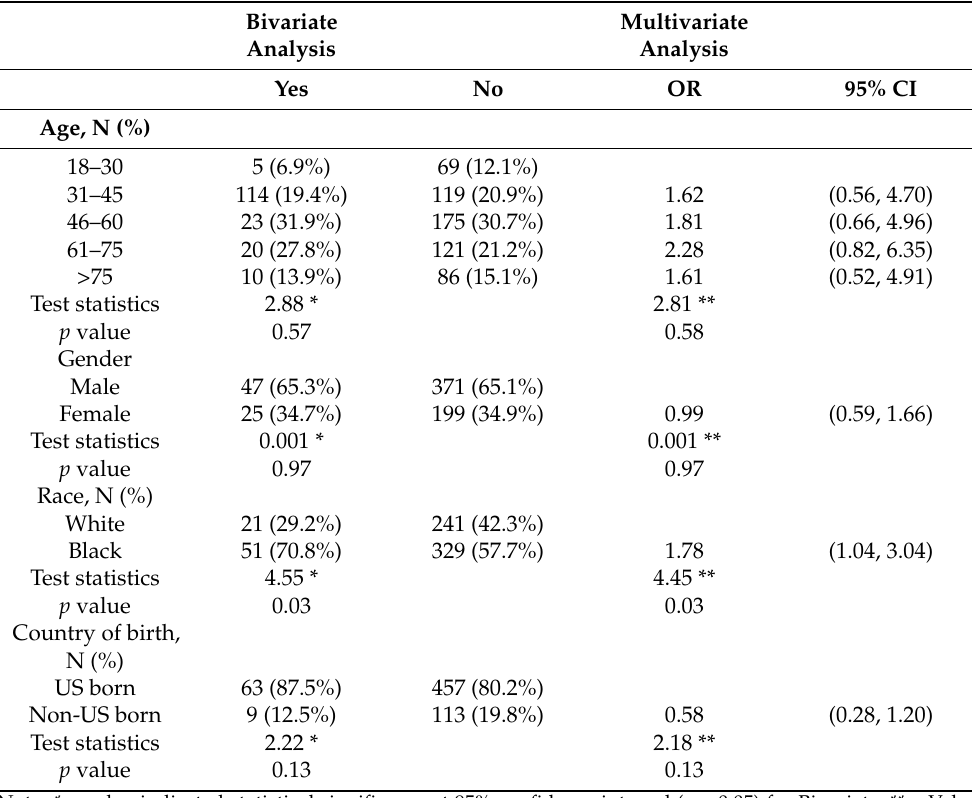
Table 2. Bivariate and multivariate analysis between previous TB and demographics.